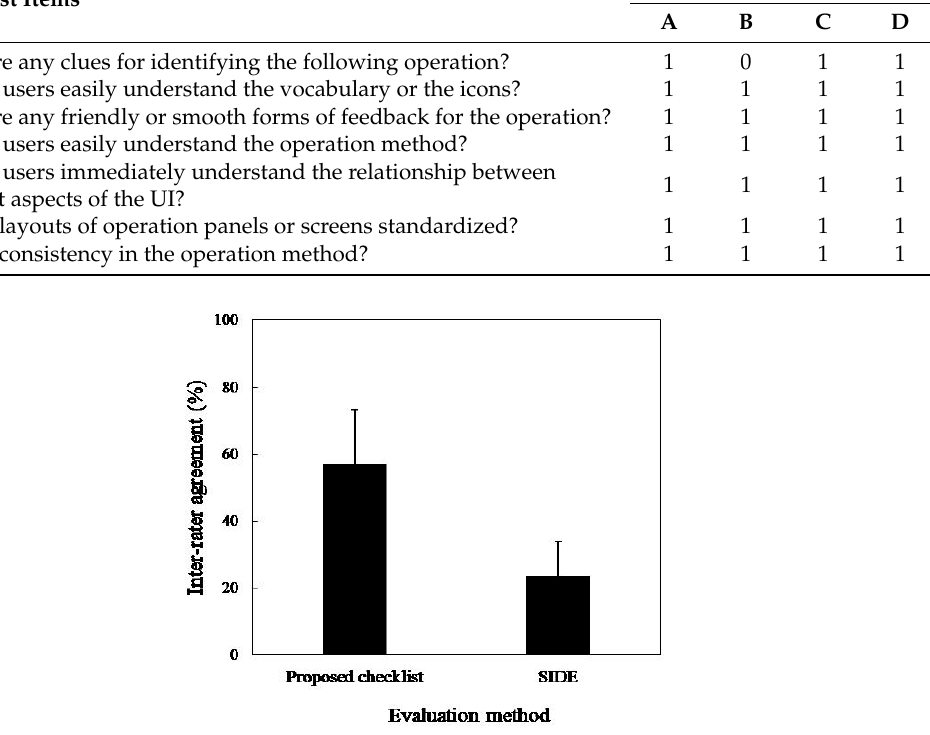
Figure 4. Mean inter-rater agreement of both checklists.